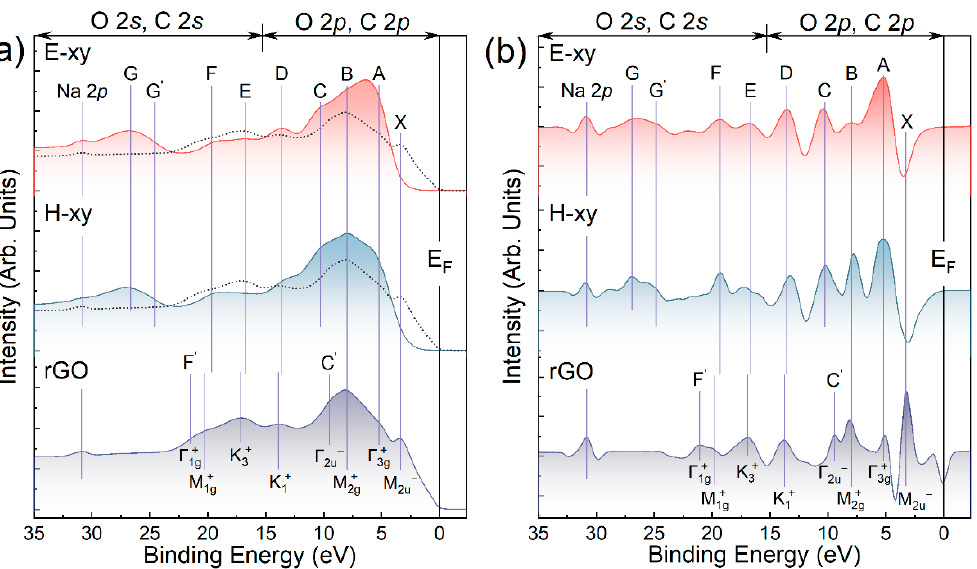
Figure 4. The original ( a ) and second-derivative ( b ) VB photoemission spectra acquired for E-xy and H-xy graphene along with rGO film.